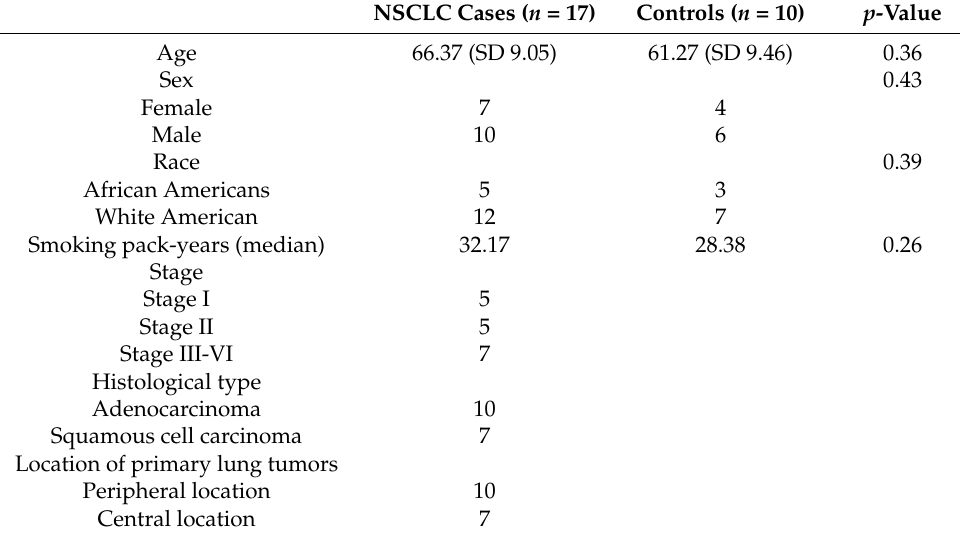
Table 1. Cohort 1 of NSCLC patients and cancer-free smokers from whom sputum specimens were collected.